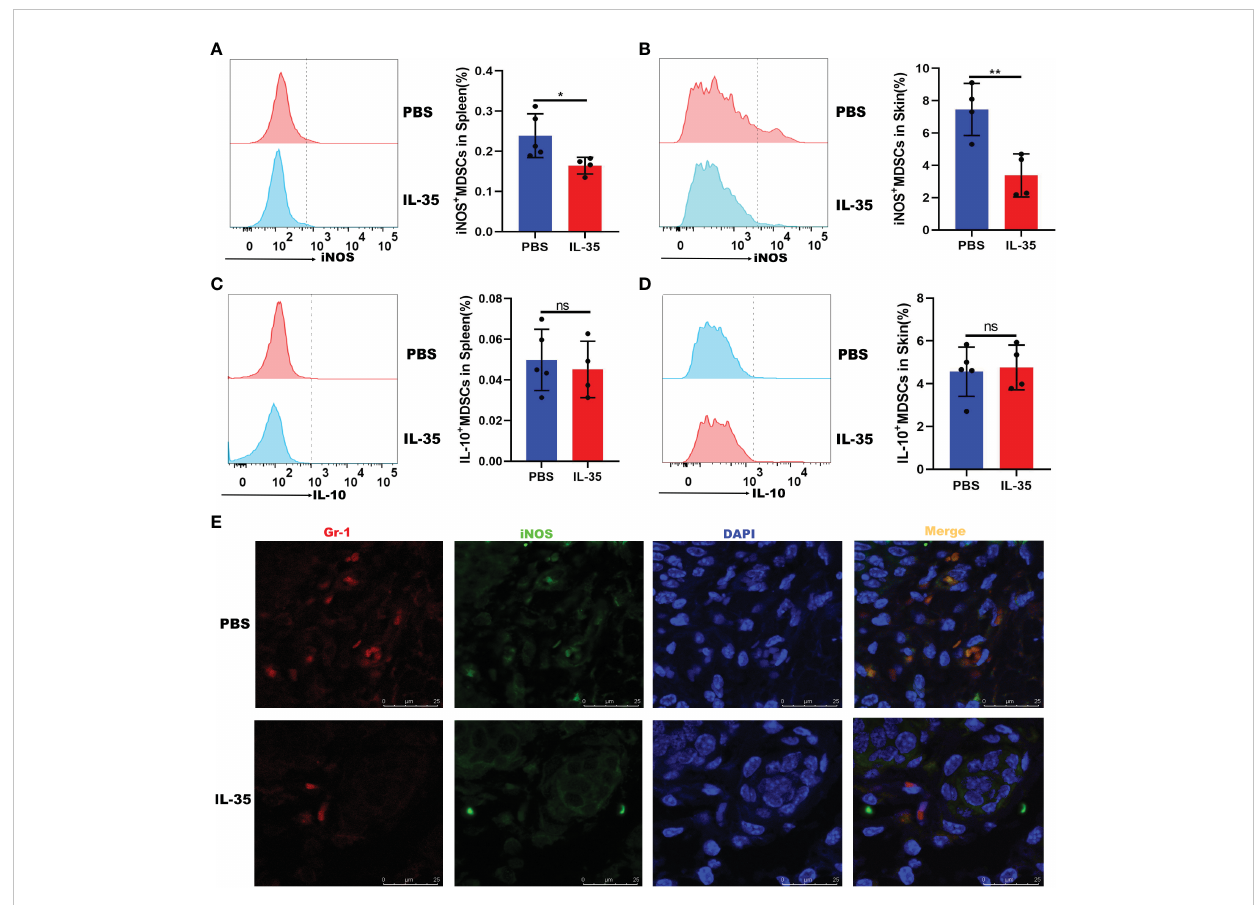
FIGURE 8 IL-35 inhibited the expression of iNOS in MDSCs. IL-35 recombinant protein was used to treat IMQ-induced psoriasis in a mouse model. The expression of iNOS and IL-10 was evaluated. Fluorescence-activated cell sorting analysis of iNOS and IL-10 expression in (A) and (C) the spleen (gated on CD11b + Gr-1 + ) and (B) and (D) the skin (gated on CD45 + CD11b + Gr-1 + ). (E) Immuno fl uorescence staining of in fi ltrated iNOS + Gr-1 + MDSCs in skin lesions (N = 5). Green represents anti-iNOS; red, anti-Gr-1; yellow, iNOS and Gr-1 merged; and blue, DAPI. Original magni fi cation, 400×. Data are presented as means ± standard deviation. *P < 0.05, **P < 0.01. DAPI, 4 ’ ,6-diamidino-2-phenylindole; IL, interleukin; IMQ, imiquimod; iNOS, inducible nitric oxide synthase; MDSC, myeloid-derived suppressor cell; ns, not signi fi